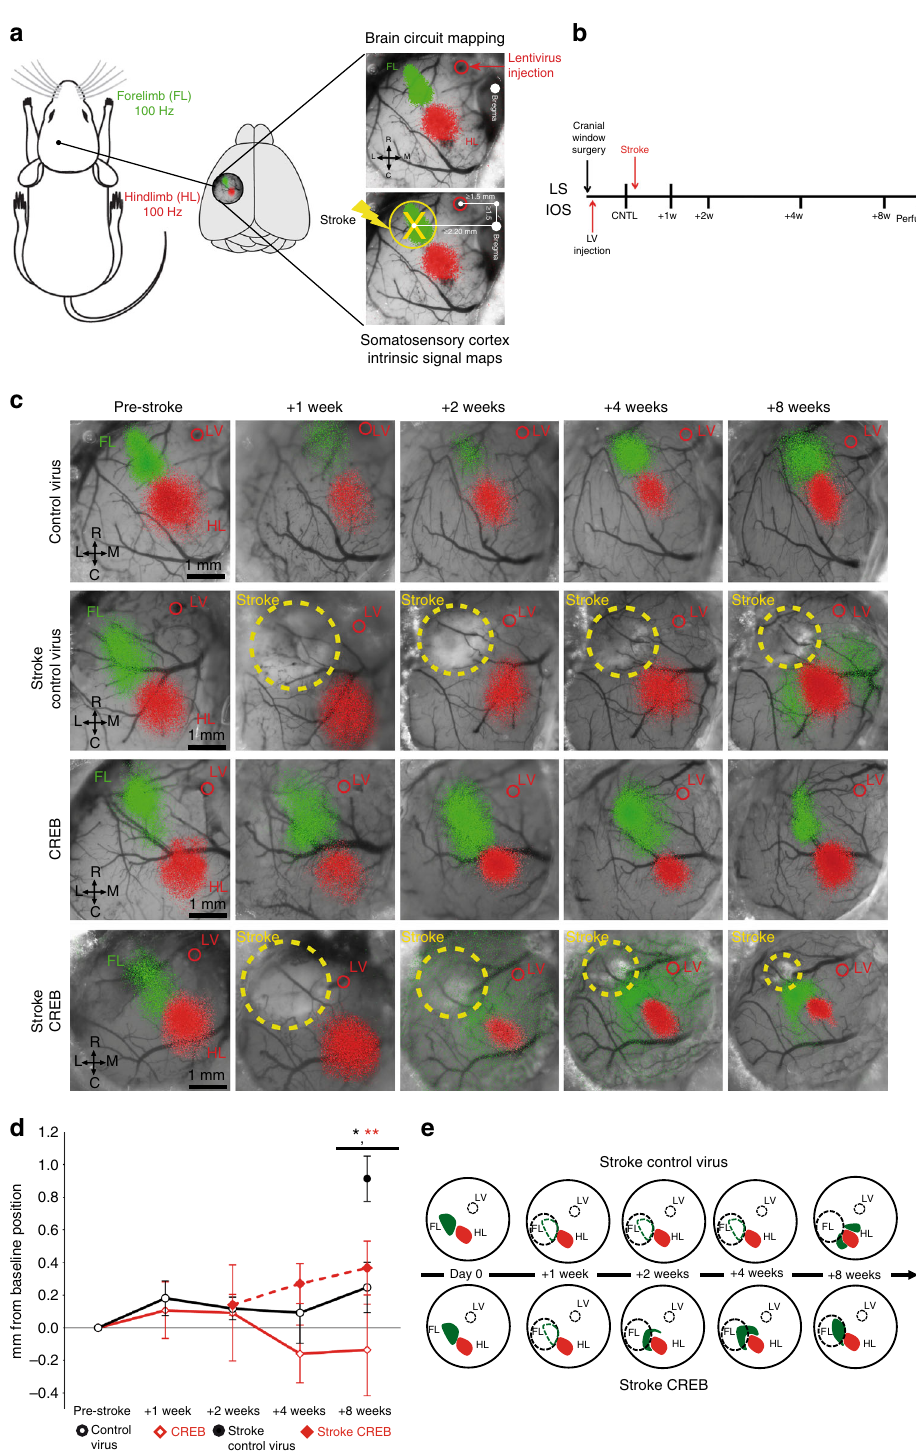
Fig. 5 CREB promotes an early remapping of the sensory forelimb map after stroke. a Intrinsic optical signaling imaging (IOS) protocol. Piezoelectric stimulation (1 s, 100 Hz) of the sensory forelimb (FL) or hindlimb (HL) during IOS. b Experimental timeline shows IOS (baseline, + 1 week, + 2 weeks, + 4 weeks, and + 8 weeks), lentiviruses injection, and targeted stroke. c Time course and regional distribution of the IOS response maps to FL (green) and HL (red) stimulation in somatosensory cortex. IOS response maps were merged with an image of the surface vasculature to create regional maps of FL and HL activation. Stroke + CREB induction produced an early (over 2 weeks) recovery of the sensory forelimb map compared with stroke + Control virus (8 weeks). This reorganization occurs in the same regional map (baseline) with no displacement toward the motor forelimb representation. d Displacement of sensory forelimb (sFL) center from its mean baseline position before and after sensory stroke. Stroke + control virus causes a signi fi cant shift (1 mm) of the FL map (evident at 8 weeks) compared with stroke + CREB. ♦♦ P < 0.001. Error bars represent SEM. n = 5 for all conditions e Schematic shows the difference in regional remapping and time course during which it occurs between stroke + control virus and stroke +